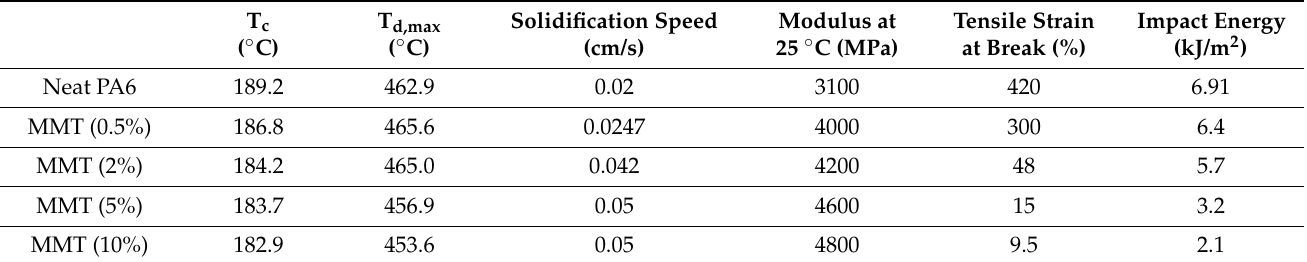
Table 1. List of crystallization temperature Tc, degradation temperature T d,max , solidification speed, tensile strain at break and notched impact energy for neat PA6 and composites at differ- ent MMT